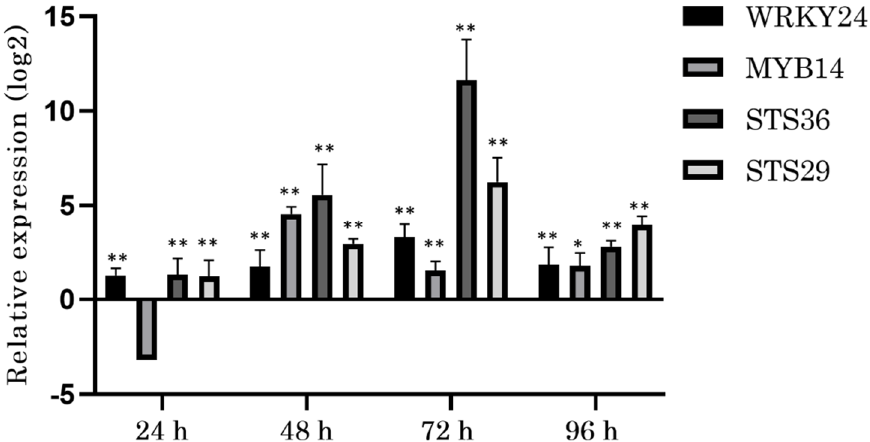
Figure 6. Analysis of expression two grapevine STS paralogs and the TFs VvMYB14 and VvWRKY24 intact Gamay leaf in response to CD elicitation. RT-qPCR analysis of VvSTS36 , VvSTS29 , VvMYB14 , and VvWRKY24 in Gamay leaves treated with 50 mM of CD up to 96 h. Expression levels were normalized to VvEF1-alpha , and represented as relative expression to control treatment. (* p -value < 0.05; ** p -value < 0.01).